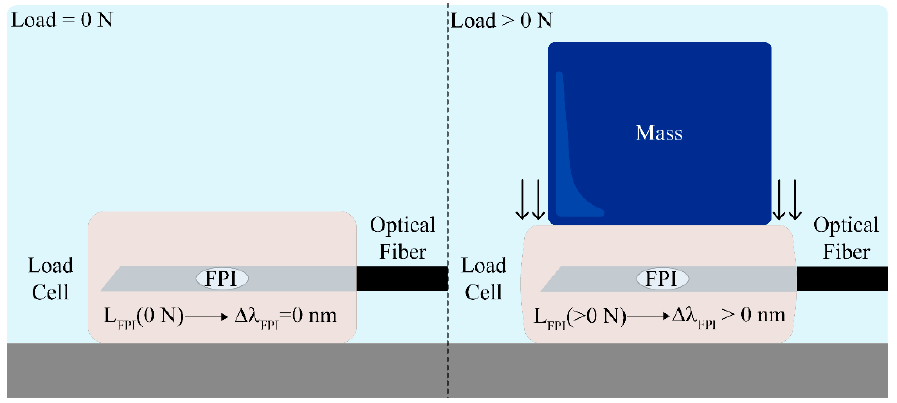
Figure 5. Schematic representation of the load cells under different load forces. For different applied mass, the FPI cavity longitudinal length (L FPI ) suffers a variation, which translates into a spectral wavelength shift ( Δλ FPI ).